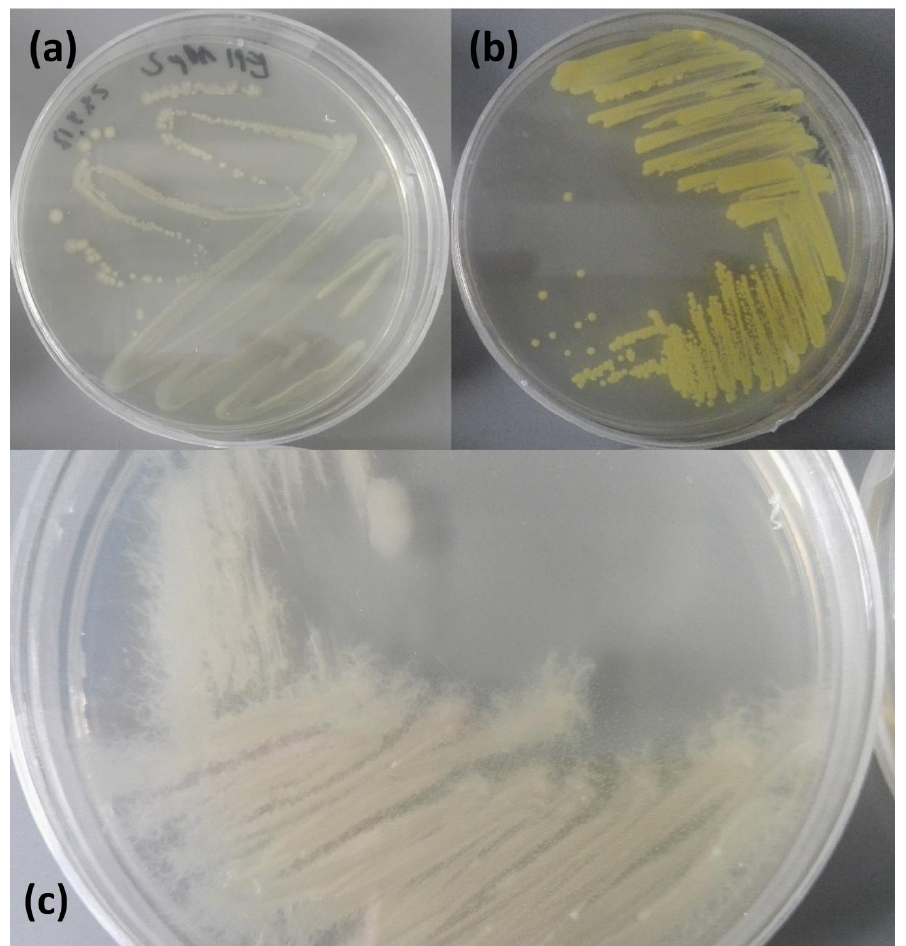
Figure 3. Examples of the most common isolates: ( a ) cream epiphyte, ( b ) yellow endophyte, and ( c ) white-cream filamentous form of epiphyte no. 37. Photo: A. Banach.